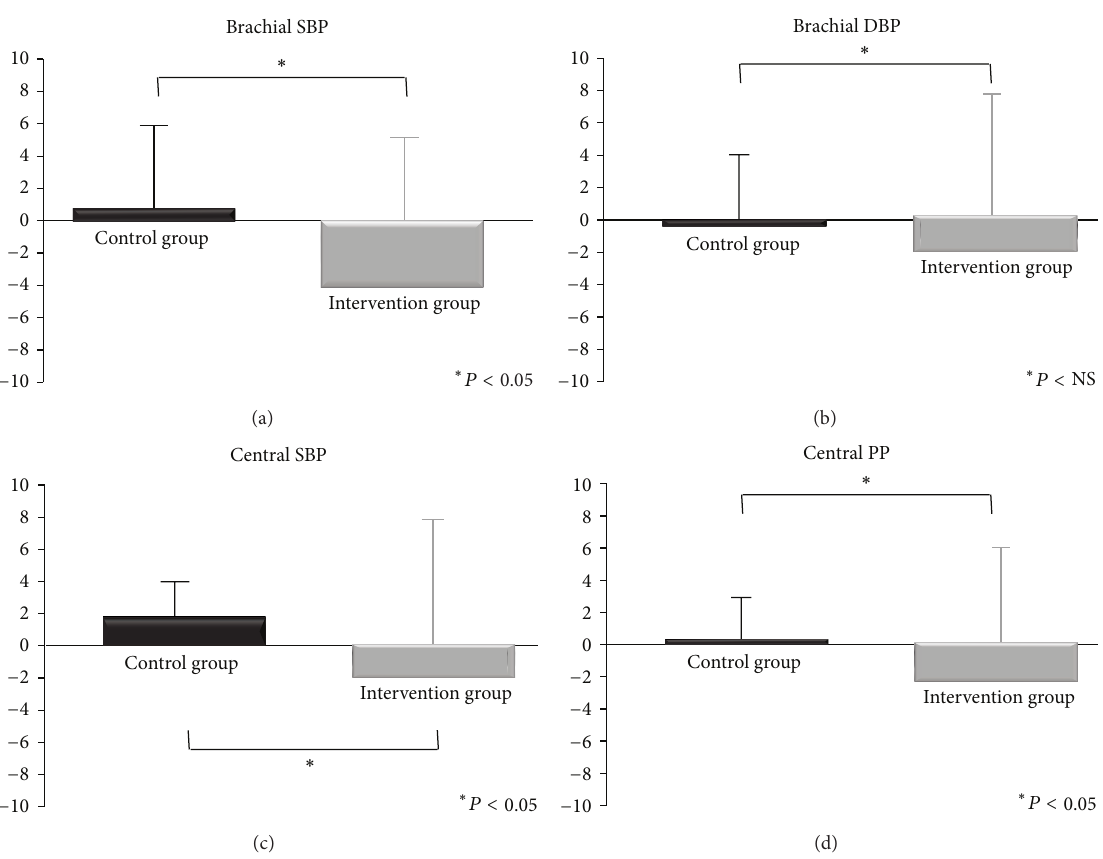
Figure 1: Differences in brachial and central blood pressure after 30 days of chocolate consumption. SBP—systolic blood pressure; DBP— diastolic blood pressure; PP—pulse